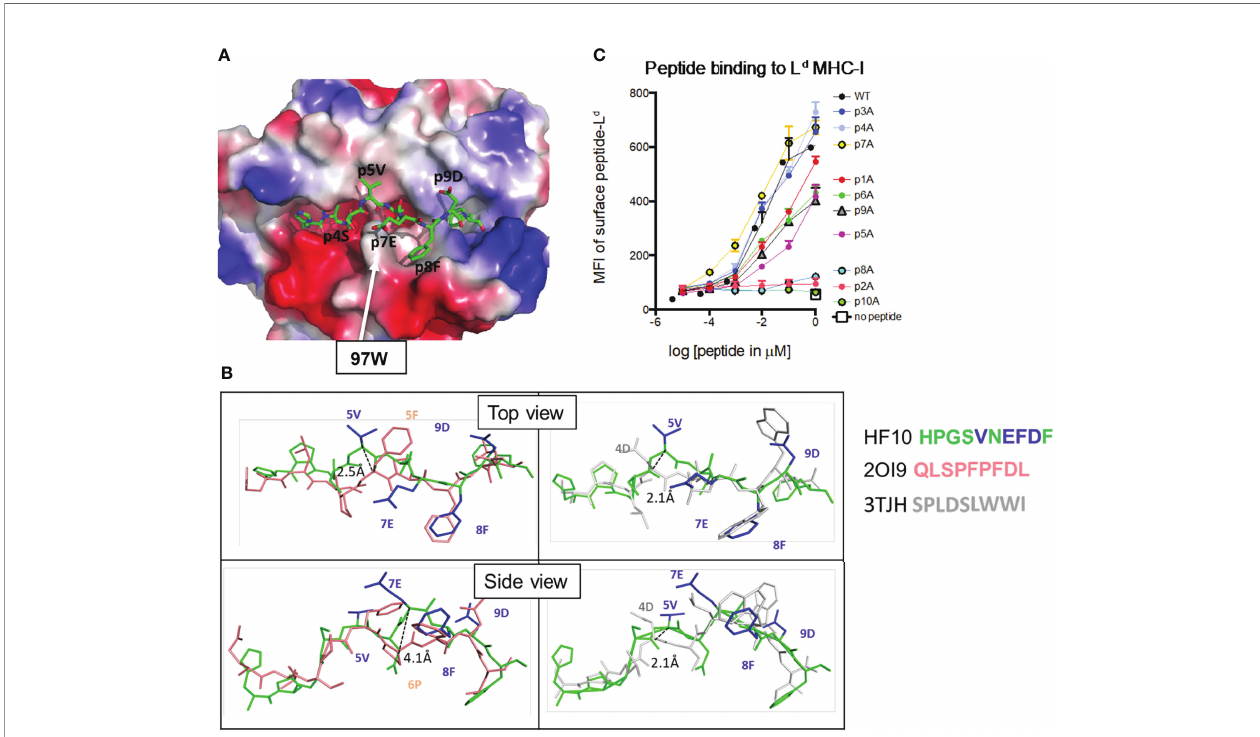
FIGURE 2 | Features of the antigenic HF10 peptide bound to H2-L d . Soluble H2-L d containing a covalently linked HF10 antigen peptide was crystallized and the structure was solved at 1.8 Å (Experimental Procedures and Supplementary Table S2 ). (A) The electrostatic surface charge of the L d molecule (with bound HF10 peptide) is shown colored by the relative charge of the surface atoms (red - negative and blue - positive). A stick representation of the HF10 peptide is colored as: carbon, green; oxygen, red; nitrogen blue. The location of W97 was indicated by an arrow. (B) Conformation of the bound HF10 peptide (green with blue side chains) in comparison to other L d -bound peptides. Peptides with a bend at p5 (HF10 and 2OI9 in pink) are on the left, and peptides with a bend at p6 (p7 for HF10) (HF10 and 3TJH in white) are on the right. See Movie S1. Additional L d -bound peptides are shown in Supplementary Figure S2 . (C) H2-L d binding to HF10 peptide alanine substitution variants. Flow cytometry surface expression (MFI) of L d on TAP-de fi cient RMA-S.L d cells incubated with increasing concentrations of the indicated HF10 or peptide variants. Data are representative of three independent